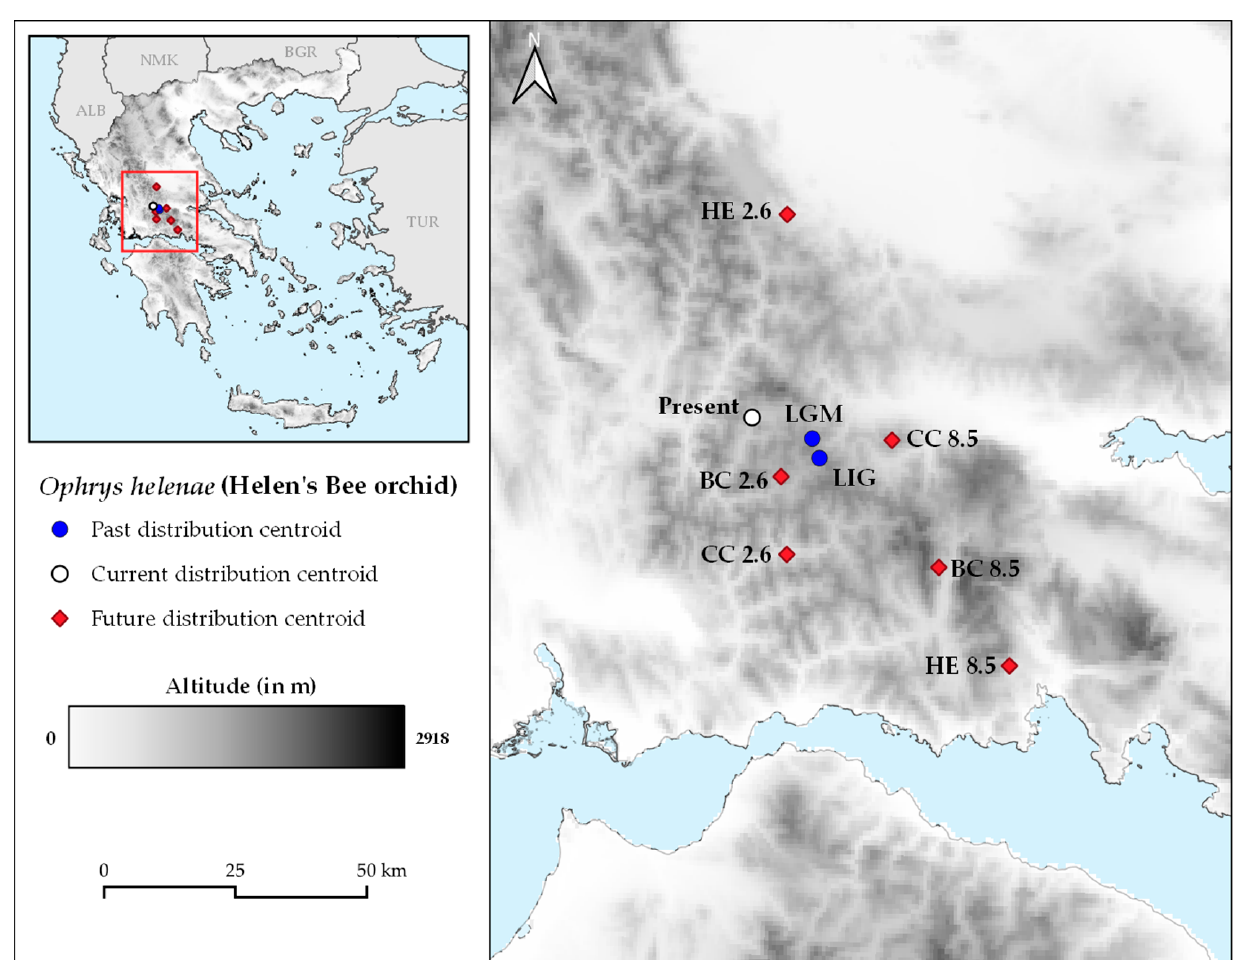
Figure 4 . Distribution centroids for current and future projected distributions of Ophrys helenae in Greece, based on the combination of CHELSA climatic database and geographical thinning procedure (CH GEO ) for occurrence data. Table 3. Mean altitude for past, present and future projections of Ophrys helenae distribution. For the past, Last Interglacial and Last Glacial Maximum (LIG and LGM, respectively) are presented, while for the future, all selected Global Circulation Models (GCMs) and Representative